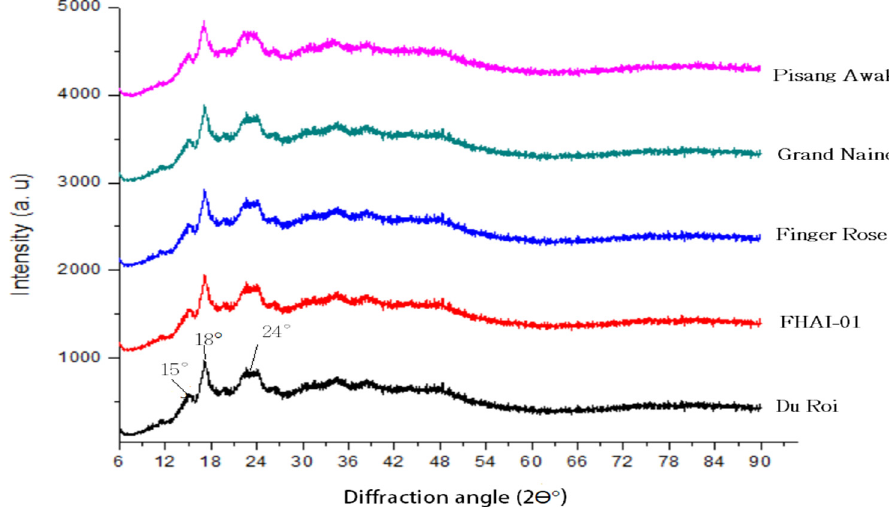
Figure 2. X-ray diffraction patterns of Pisang Awak, Grand Naine, Finger Rose, FHIA-01 and Du Roi.